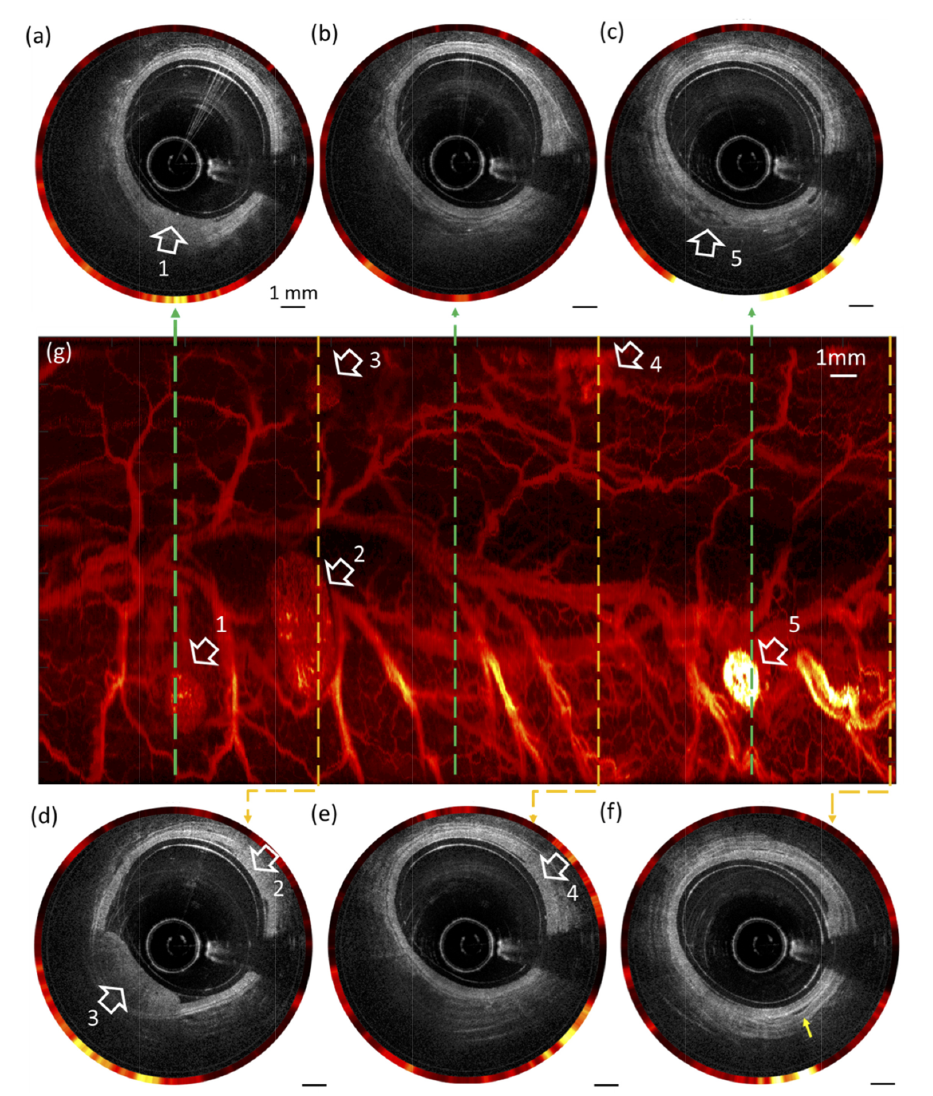
Figure 6. Combined OCT and fluorescence images ( a – f ) and en-face fluorescence image ( g ) of a colorectal wall from a rat model injected with ICG intravenously. White arrows show identified lesions. Image reprinted with permissions from ref. [36]. Copyright 2019